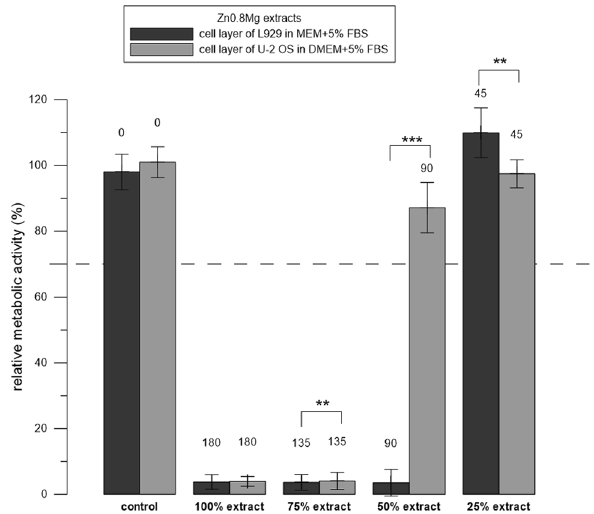
Figure 5. Relative metabolic activity of the cells (resazurin assay) after 24 h incubation with extracts of Zn0.8 Mg. Three replicates 1–3 were used. The extract was added either to L929 or to U-2 OS cells. Sole extraction medium served as a control (unaffected cells which metabolic activity was taken as 100%). Numbers above the columns stand for the concentration of measured Zn in µM. The dashed line stands for the normative limit of 70% metabolic activity of the control. Error bars stand for the standard error deviation of six measurements. Significance codes according to p value: 0 ‘***’0.001 ‘**’0.01 ‘*’0.05 (two-sample